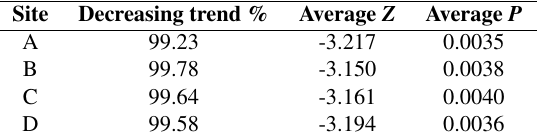
Table 2. Monotonic trend assessment results